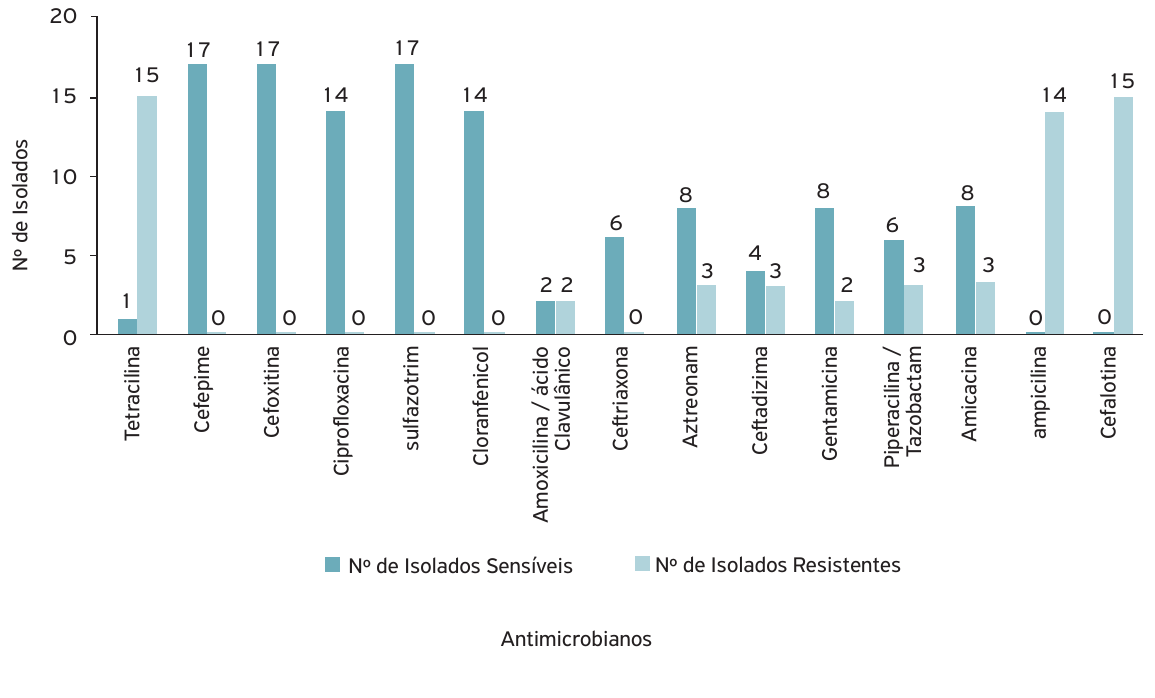
Figura 2. Perfil antimicrobiano de E. coli